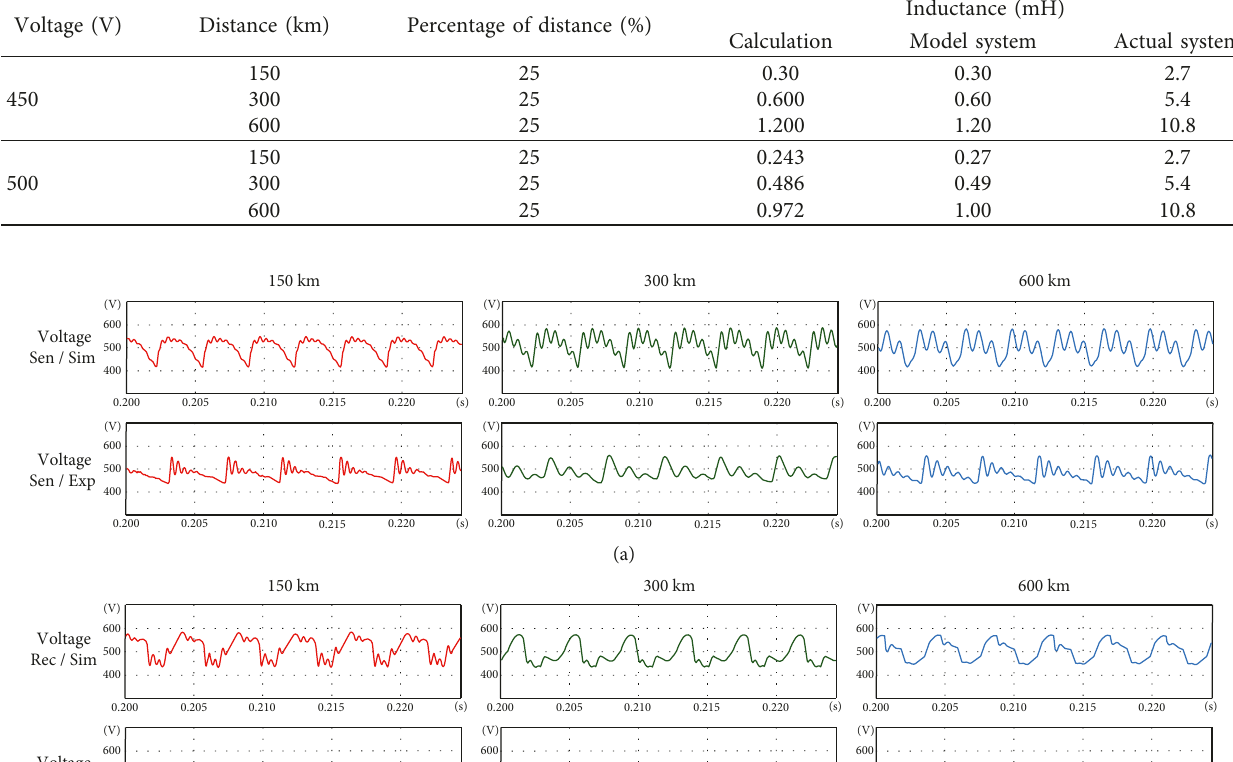
Table 6: Capacitance of the HVDC transmission line model at different voltages and distances.